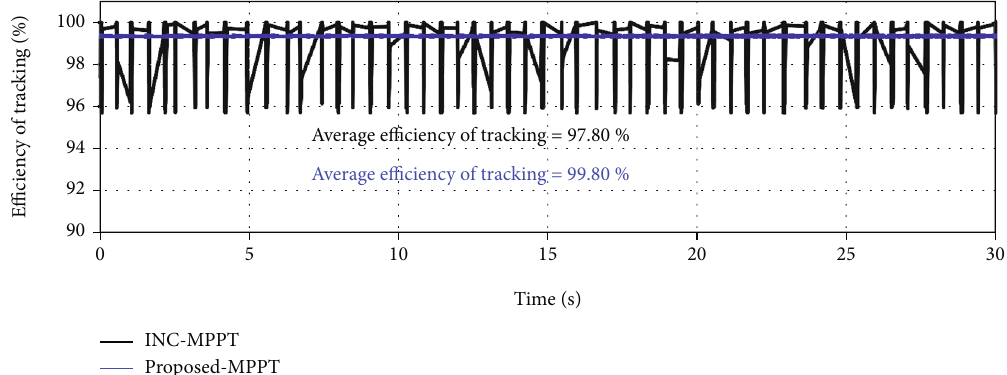
Figure 28: RT-LAB real-time results of the tracking e ffi ciency comparison waveforms of both MPPT schemes under